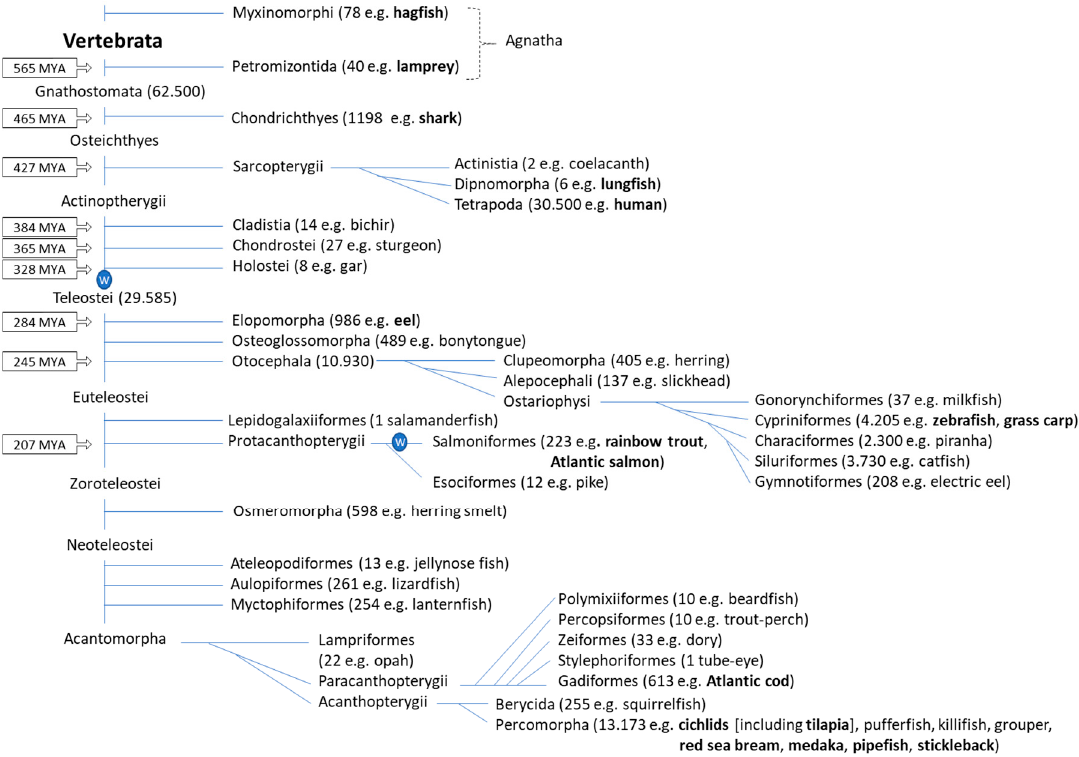
Figure 1. Schematic overview of fish classification. The organization of fish clades, and the estimated number of species which is indicated between brackets for some of them, are based on Nelson et al., 2016 [96]. Also between brackets, simplified popular English names of fish species representative for the clade are given; fish species that are important in the main text are highlighted in bold. For some nodes the time of separation in million years ago (MYA) is given as calculated in [98]. Circles with the letter W refer to whole genome duplication events early in the lineages Teleostei and Salmoniformes. Fish phylogeny and species numbers are under continued discussion, and the figure should be